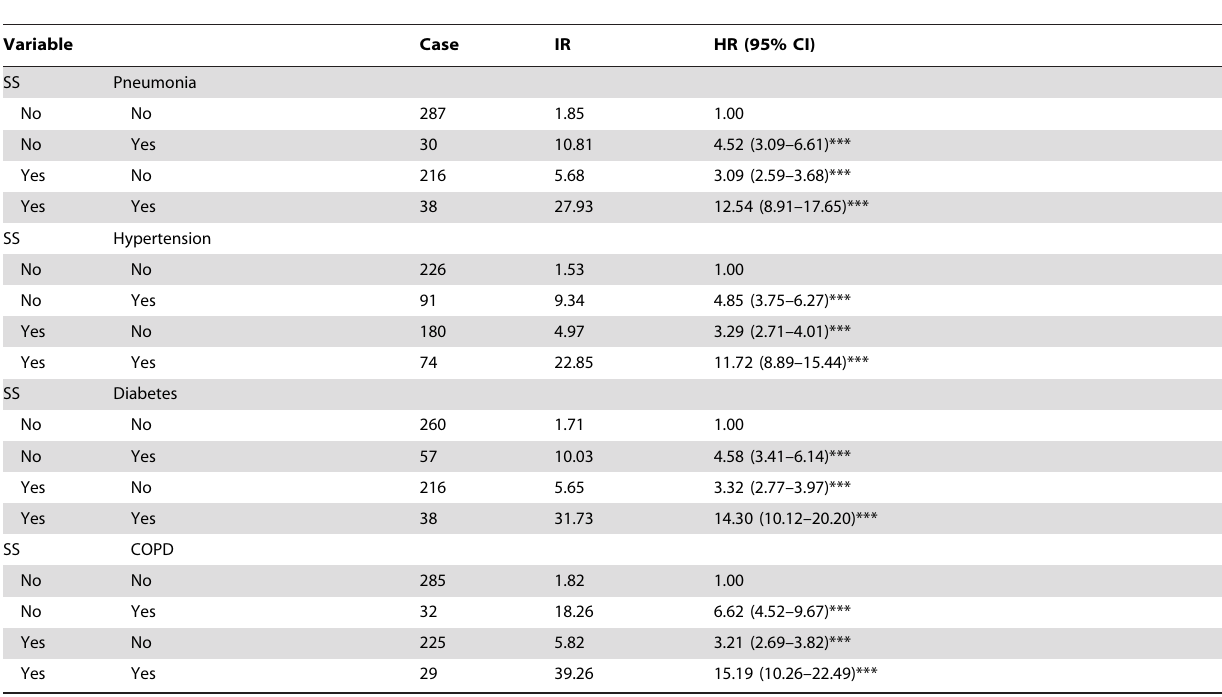
Table 3. Joint effect of SS and comorbidity in association with respiratory failure in study population.